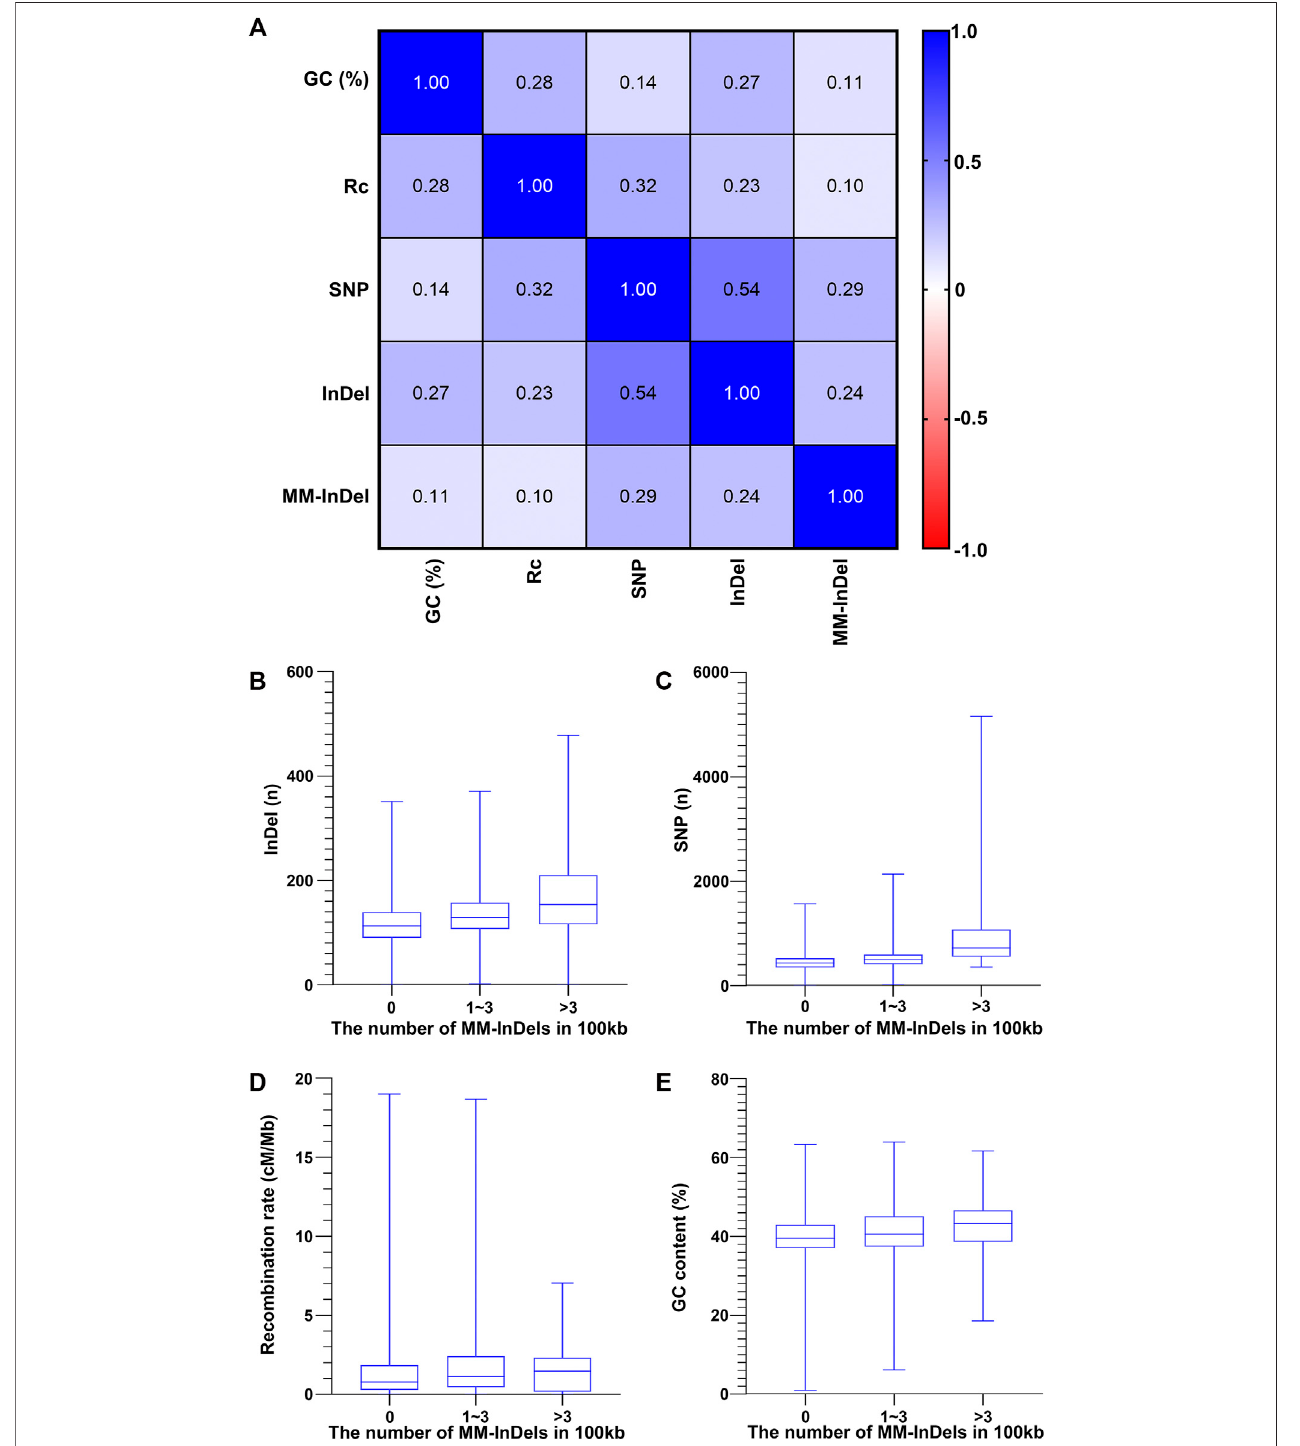
FIGURE 4 | Relationship between the occurrence of MM-InDel markers with random sequences and different genomic factors. (A) Correlation analysis between the density of MM-InDels with random sequences and genomic factors such as the density of SNPs, the density of InDels, GC contents [GC (%)], and recombination rates (Rc). The average value for 100-kb bins is utilized. p -values were all < 0.0001. (B – E) Correlation of MM-InDels harboring random sequences with the density distribution of InDels (B) , SNPs (C) , GC content (D) , and recombination rate (E) .